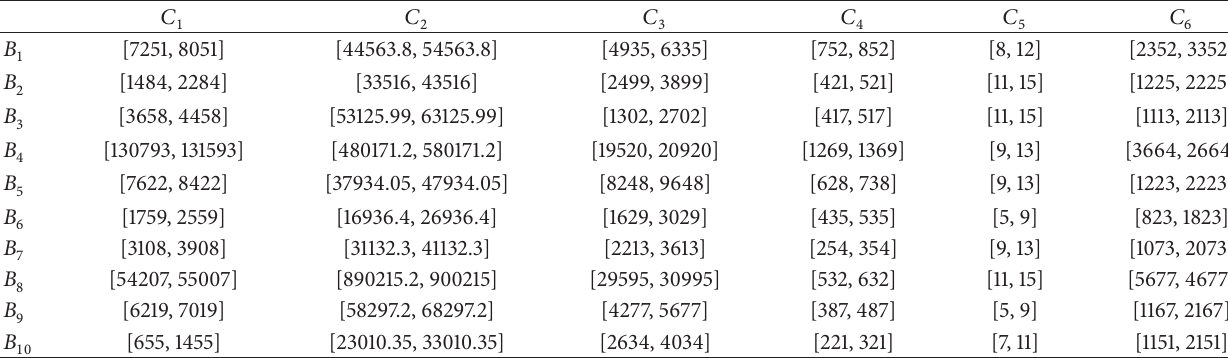
Table 9: Interval decision matrix in the second-time period (year of 2005).